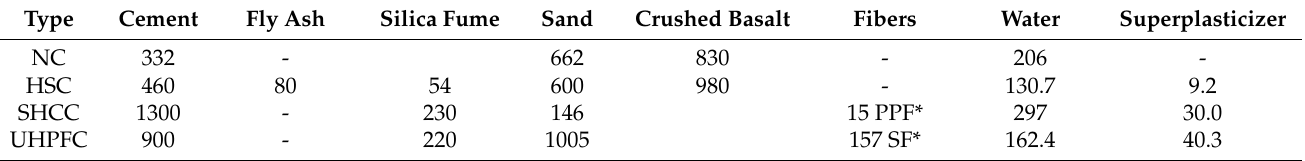
Table 2. Weight in kilograms of components for preparing a cubic meter of each type of concrete.